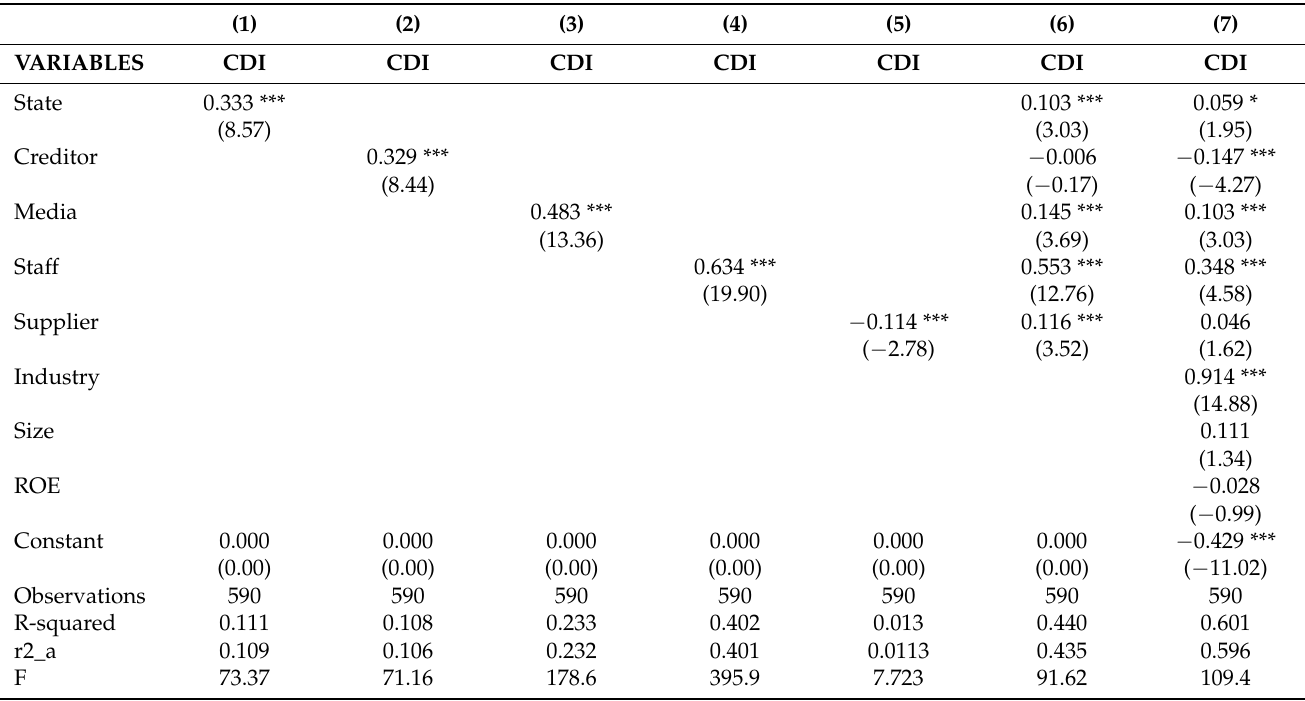
Table 8. Robustness test results (change in variable